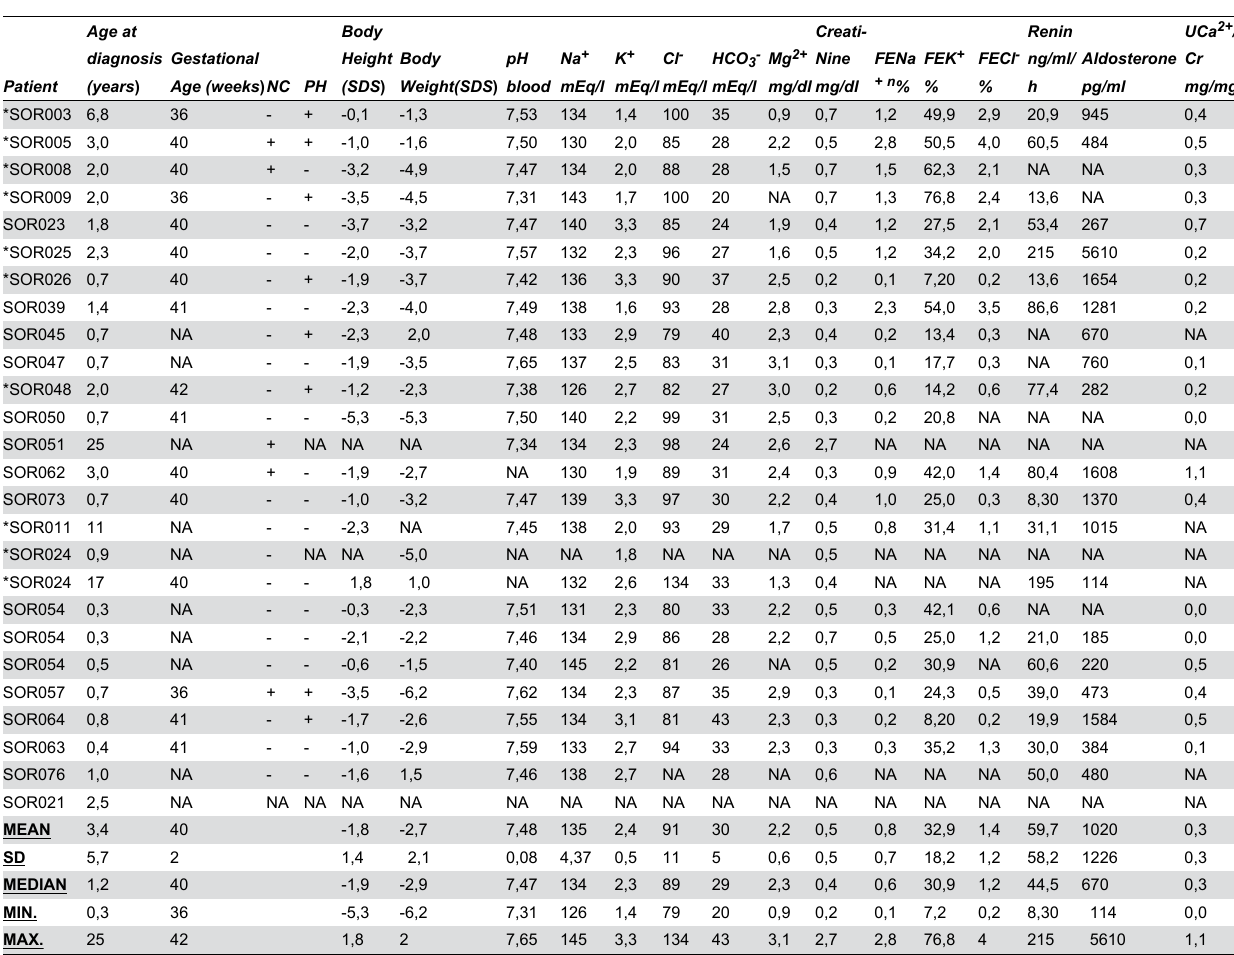
Table 1. Clinical and biological characteristics of BS patients.